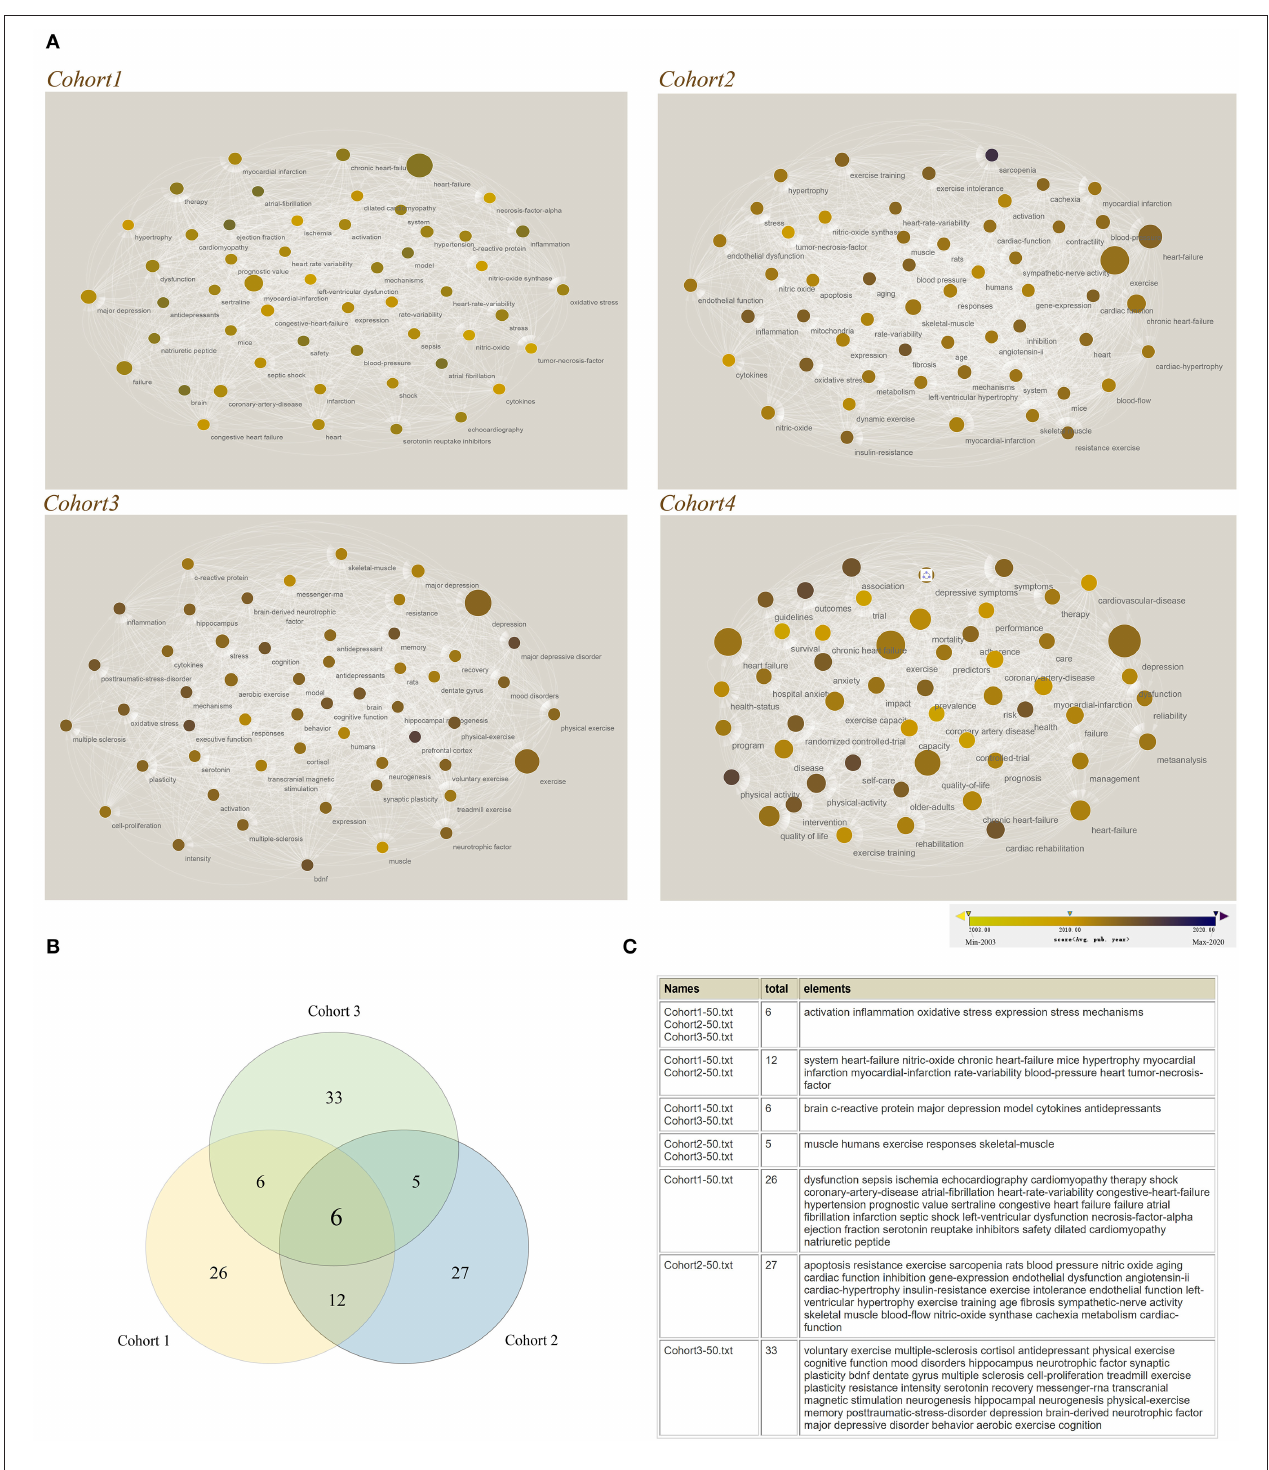
FIGURE 3 | Hotspot analysis of related keyword-driven research based on the keyword co-occurrence. (A) Construct keywords sub-network for the top 50 keywords of four cohorts through VOSviewer and Cytoscape software. The diameter and the color of the dots reflected weighted co-occurrence and the changes in the timing, respectively; (B) Keyword intersection of three retrieval sequences; (C) Detailed information about the results of keyword intersection.